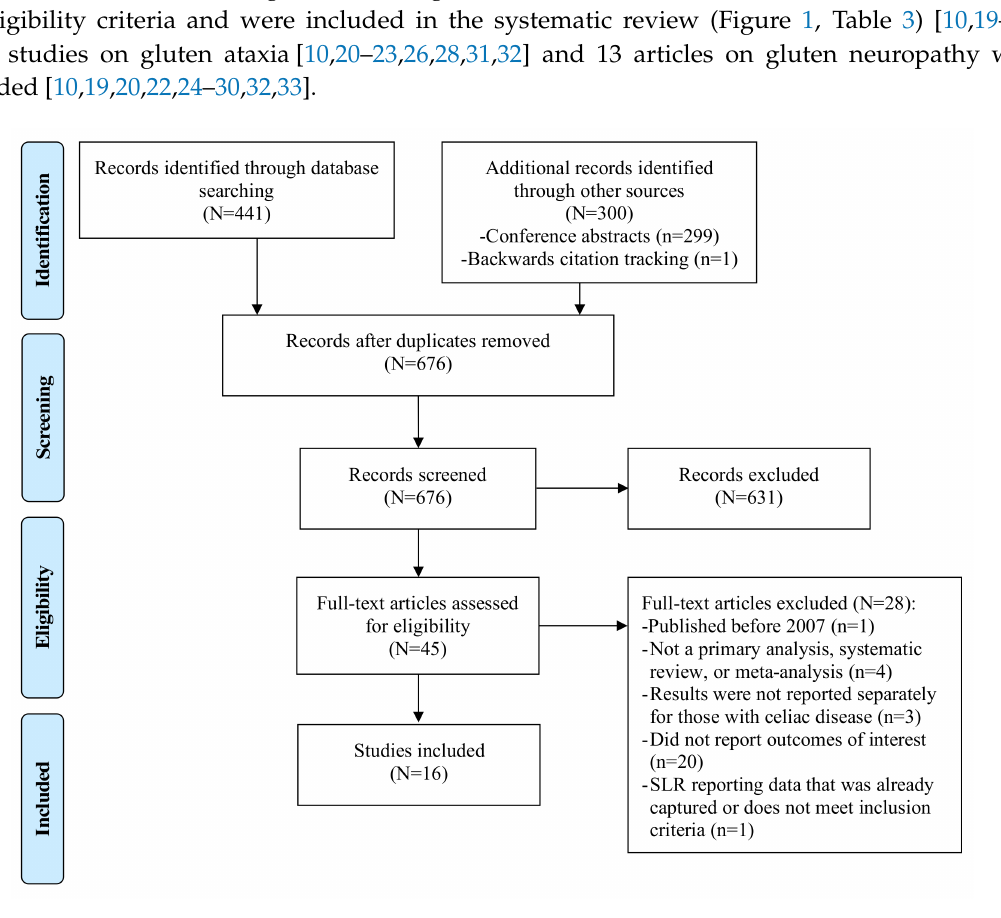
Figure 1. Flow Diagram Showing the Results of the Literature